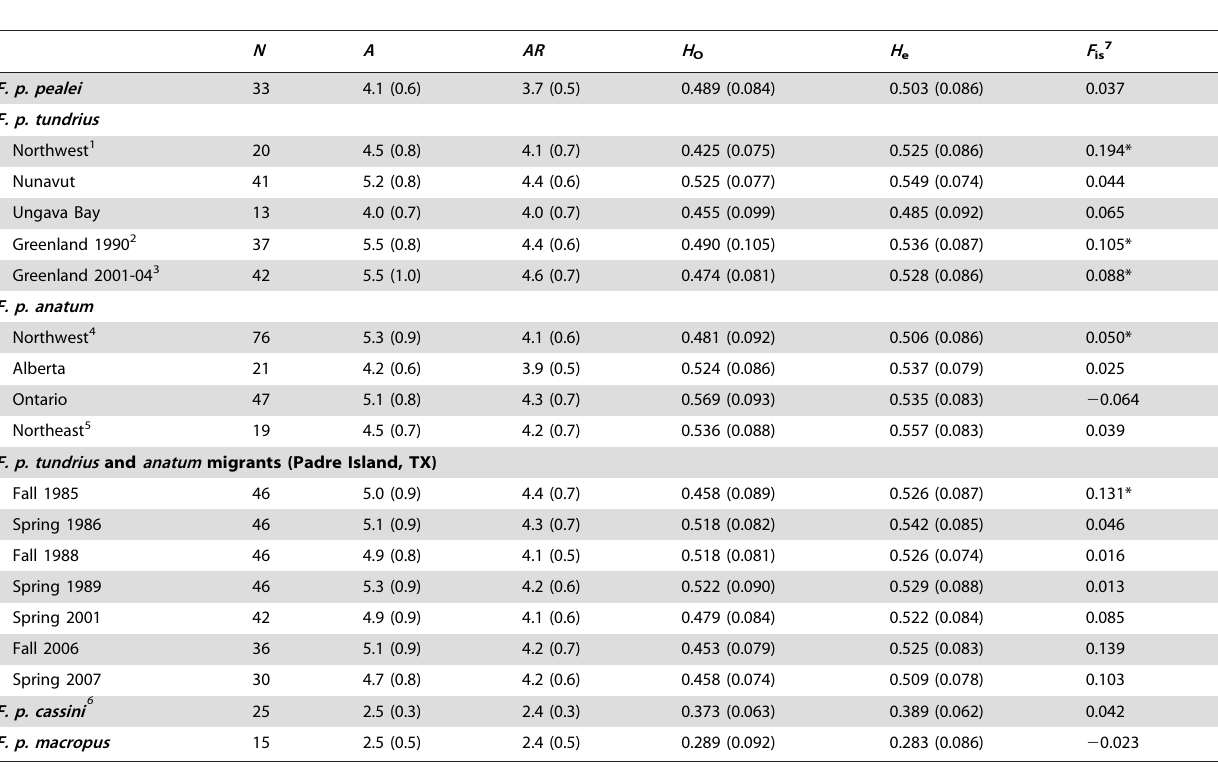
Table 1. Levels of nuclear microsatellite genetic diversity (11 loci) for regional peregrine falcon sample locations.